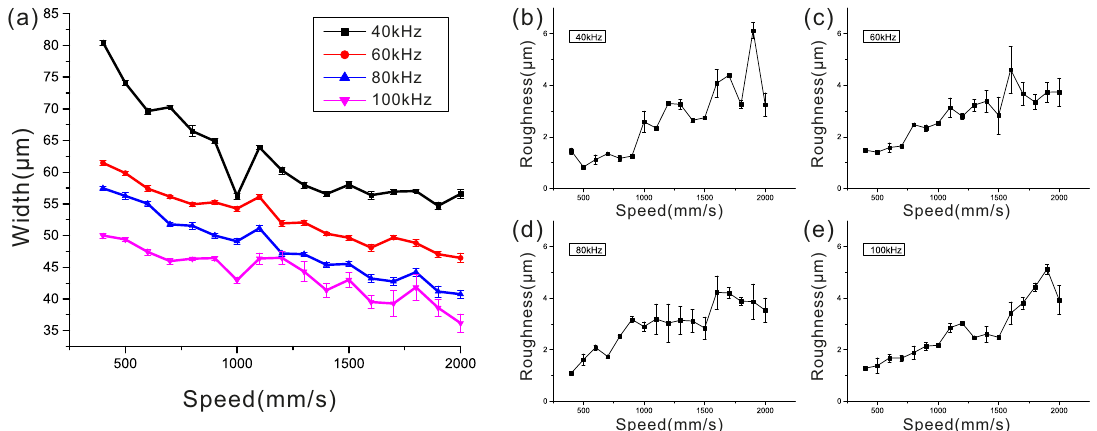
Figure 2. The variation tendency in width and roughness at different parameters. ( a ) the actual width of the structures versus laser scanning speed for different laser pulse repetition rates (the designed width is 30 µm); and ( b – e ) the measured roughness of the structures versus laser scanning speed for different laser pulse repetition rates (the designed width is 30 µm).